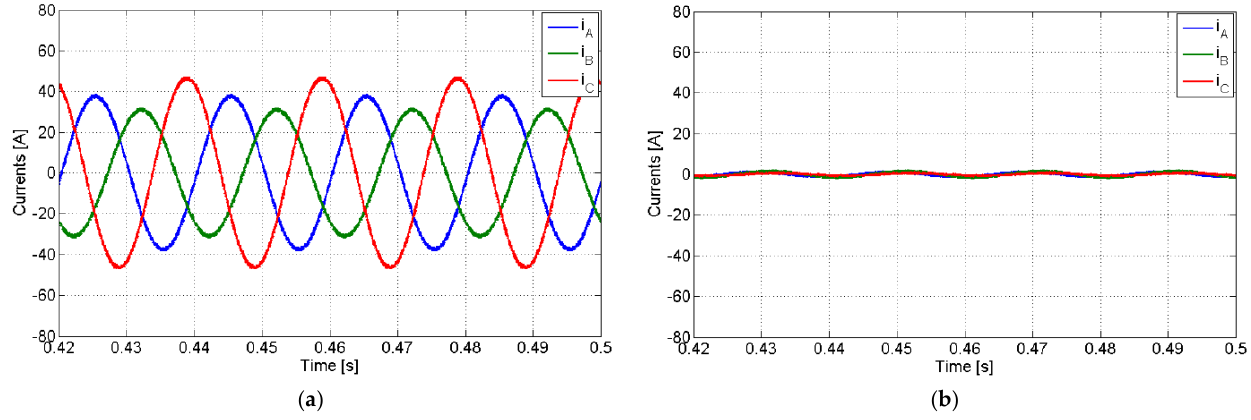
Figure 14. Simulation results with the PV generator in subcompensation mode with a linear load and compensation of the active and reactive power imbalances: ( a ) AC currents of the PV generator; ( b ) grid currents.